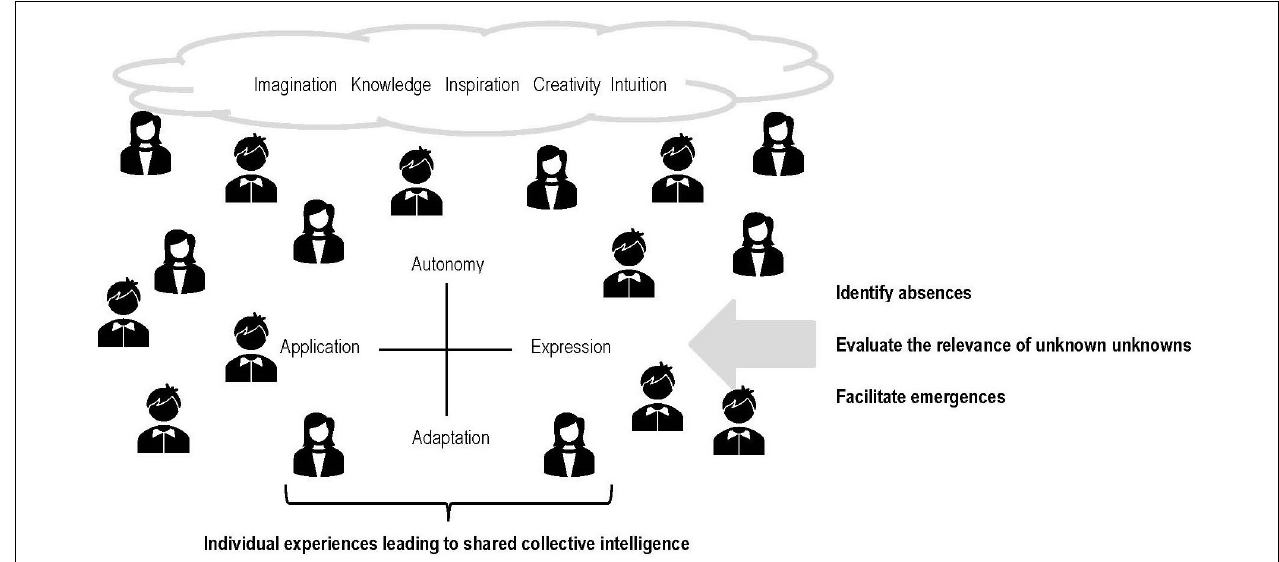
FIGURE 1 | Visual representation of the theoretical framework, drawing on Santos (2016) and the previous studies (Usher et al., 1997; Usher, 2018).